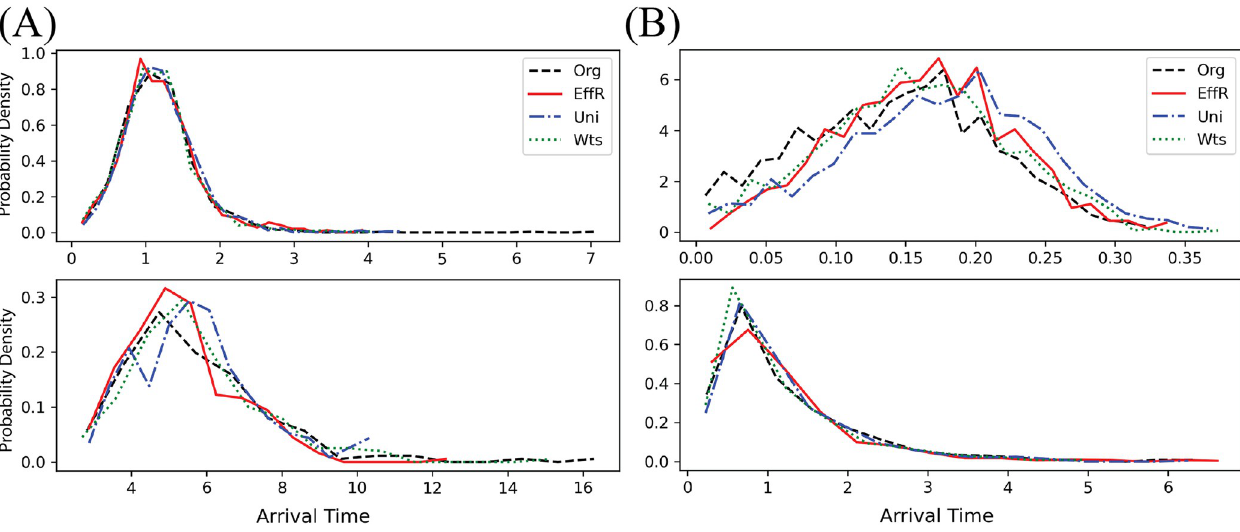
Fig 4. Sparsification of the U.S. mobility network: representative arrival time distributions. Arrival time distributions for the original network (Org) and sparsified networks produced by the three edge-sampling methods with 7% of the original edges preserved. In each graph, we show the probability density of the time at which a particular node becomes infected, conditioned on the event that it becomes infected during the epidemic. We show this distribution for two representative nodes (top and bottom) under (A) the localized initial condition and (B) the dispersed initial condition. The top node is in a well-connected part of the network, with typical arrival times ranging from 0.5 to 1.8 in the localized initial condition and from 0.05 to 0.25 in the dispersed initial condition. The bottom node is in a sparser region and more remote from the initial infection, giving it arrival times of 3–8 and 0.2–1.5 in the localized and dispersed initial conditions respectively. All three edge-sampling methods do fairly well at reproducing the shape of these arrival time distributions.